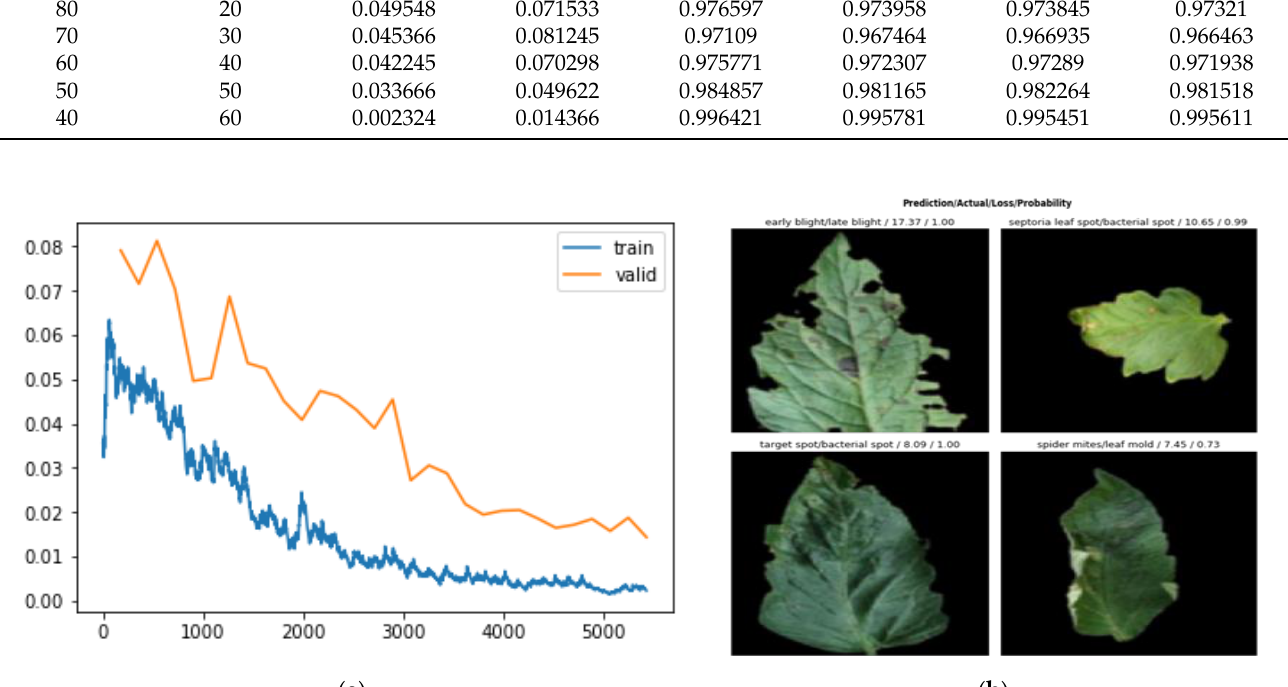
training and validation data split ratios. Figure 11 shows the areas of mistake recorded by the model in this research: (a) the plot loss for a network depth of 152; (b) the images the model predicted wrongly for a network depth of 152, detailing the predicted, ground truth, loss, and probability values.